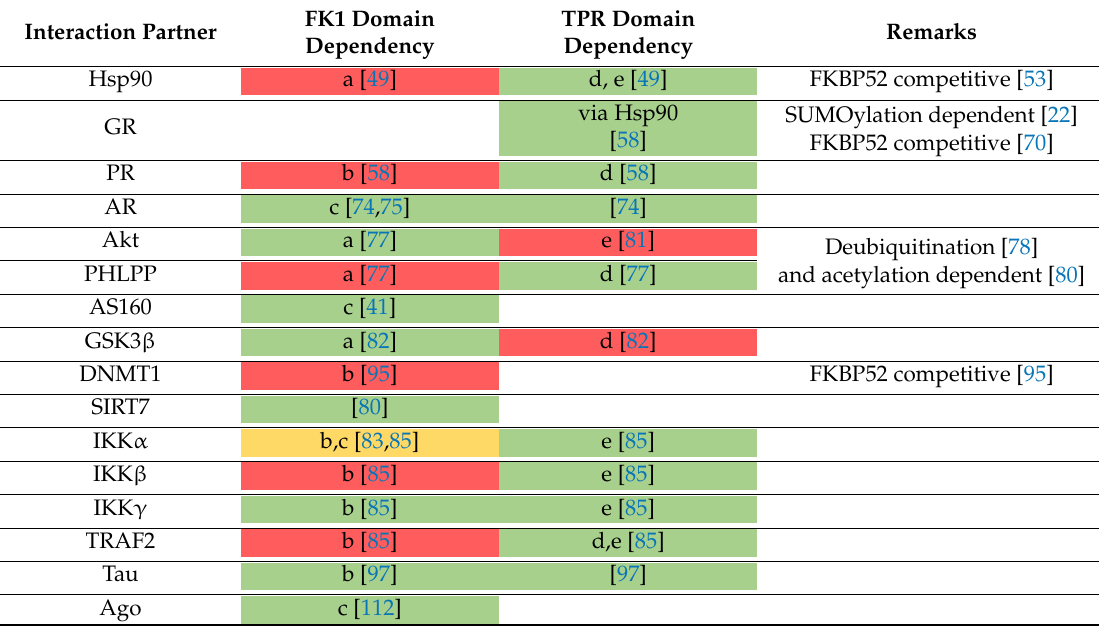
Table 1. Overview of FKBP51 interaction